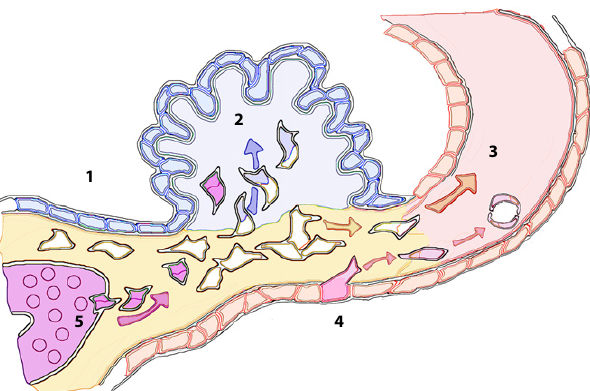
Figure. 4 Model of proepicardial cell lineages. (1) The PE is mainly derived from pericardial mesothelium (blue) and underlying mesenchymal cells of the sinus venosus (yellow). (2) This pericardial mesothelium forms villous protrusions, which are generated by the proliferation of mesothelial cells at the base of the PE, recruitment of sinus mesenchyme and the accumulation of extracellular matrix proteins in the PE core. This combination of processesgeneratesthecharacteristiccauliflowerPEmorphology.Thesinusmesenchyme,whichisrecruitedto the PE can also become myocardium, therefore some of these mesenchymal cells might still retain the ability to switchbacktothemyocardiallineageafterBMPstimulationorlossofNotchsignaling.(3)Themyocardiumofthe inflow tract (red) continuously grows by proliferation and recruitment of sinus mesenchyme thereby elongating the heart tube. (4) The endothelium of the inflow tract partially dedifferentiates and invades the myocardium to form coronary veins, which connect the epicardium-derived coronary arterial vessels with the inflow tract of the heart. (5) The liver primordium might be the source for the coronary endothelium, which enters the PE and is thereby transferred to the heart to generate the arterial